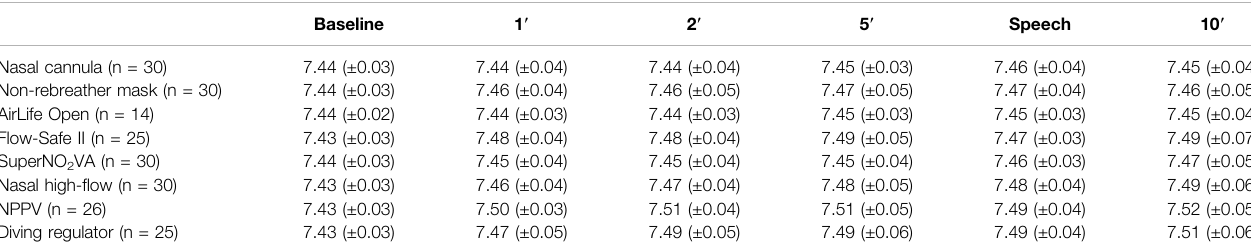
TABLE 3 | Mean arterial pH during breathing with the different oxygen systems (mean and standard